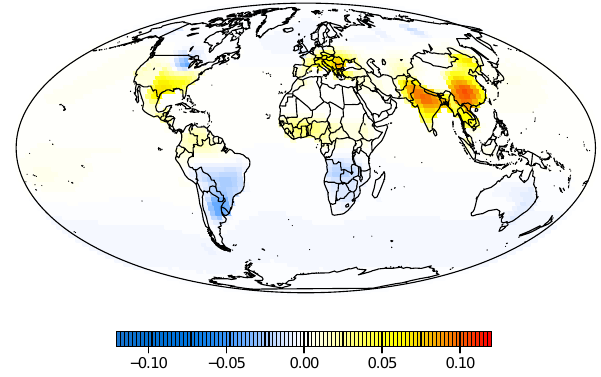
Fig. 6. Mean N 2 O flux increments (a posteriori minus a pri- ori fluxes) for the period 1999–2009 shown for IAVA (units of gm − 2 a − 1 N).